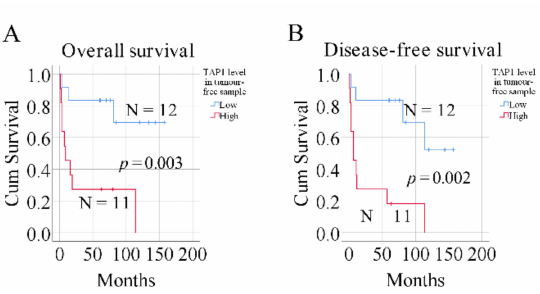
Figure 2. The influence of TAP1 levels in tumor-free samples on patient survival. Kaplan–Meier curves of overall ( A ) and disease-free ( B ) survival. Blue lines represent patients with low TAP1 levels, and red lines patients with high TAP1 levels. Log-rank test for overall ( p = 0.003) and disease-free survival ( p = 0.002). N = number of